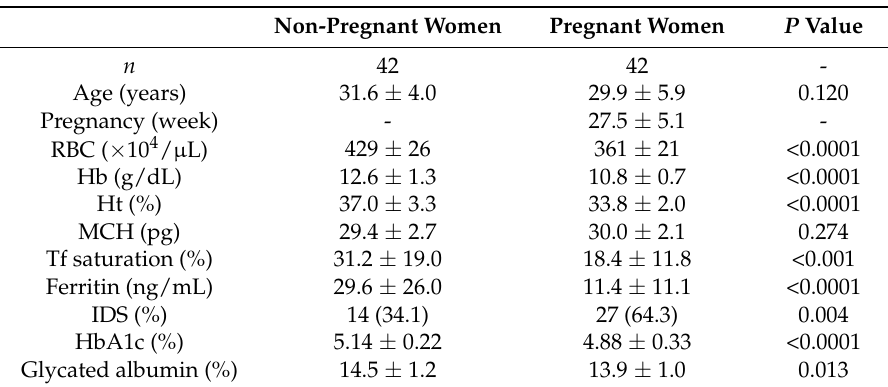
Table 1. Clinical characteristics of study